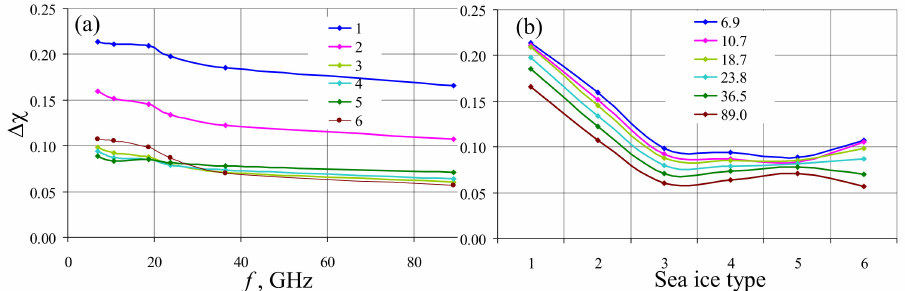
Figure 5. Dependence of polarization difference ∆ χ f on ( a ) frequency, ( b ) sea ice type. 1—nilas, 2—young ice, 3—thin FY ice, 4—medium FY ice, 5—thick FY ice, 6—MY ice.